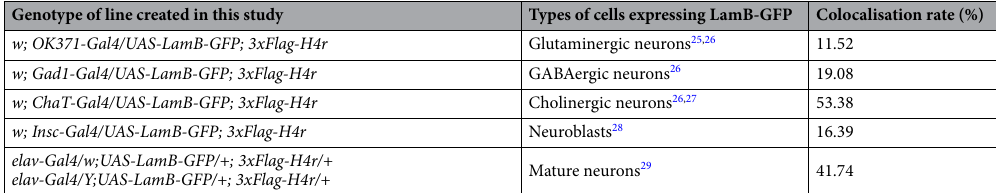
Genotype of line created in this study Types of cells expressing LamB-GFP Colocalisation rate